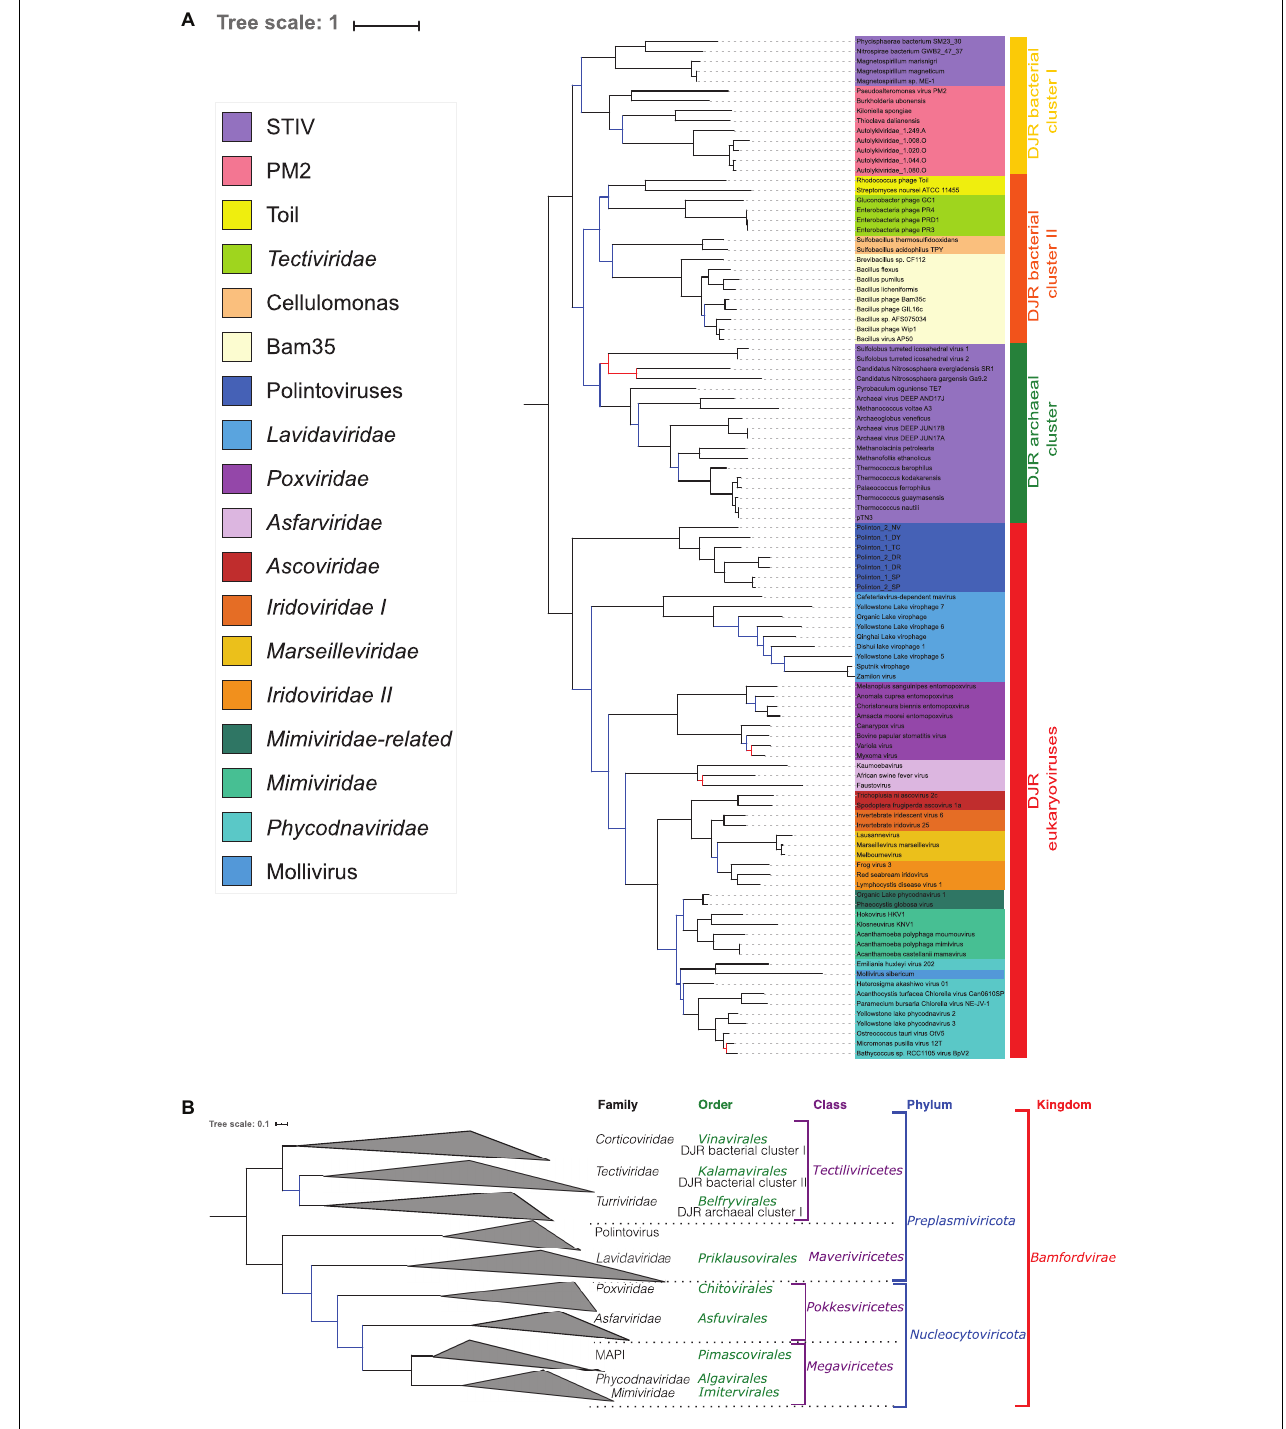
FIGURE 3 | Phylogenetic tree of the concatenated MCP and pATPase genes. (A) Phylogenetic tree annotated with the corresponding group. The alignment has 103 sequences with 408 positions. Phylogenetic tree was rooted between the prokaryotic and eukaryotic members. The scale-bar indicates the average number of substitutions per site. The best-fit model was LG + F + R6, which was chosen according to Bayesian Information Criterion (BIC). Branches in black indicate both classical bootstrap and transfer bootstrap expectation (TBE) support using 1,000 replicates values are above 70%. Branches in blue indicate only one of the two support values is above 70% whereas branches in red indicate both support values are below 70%. (B) Phylogenetic tree annotated with the ICTV taxonomy.